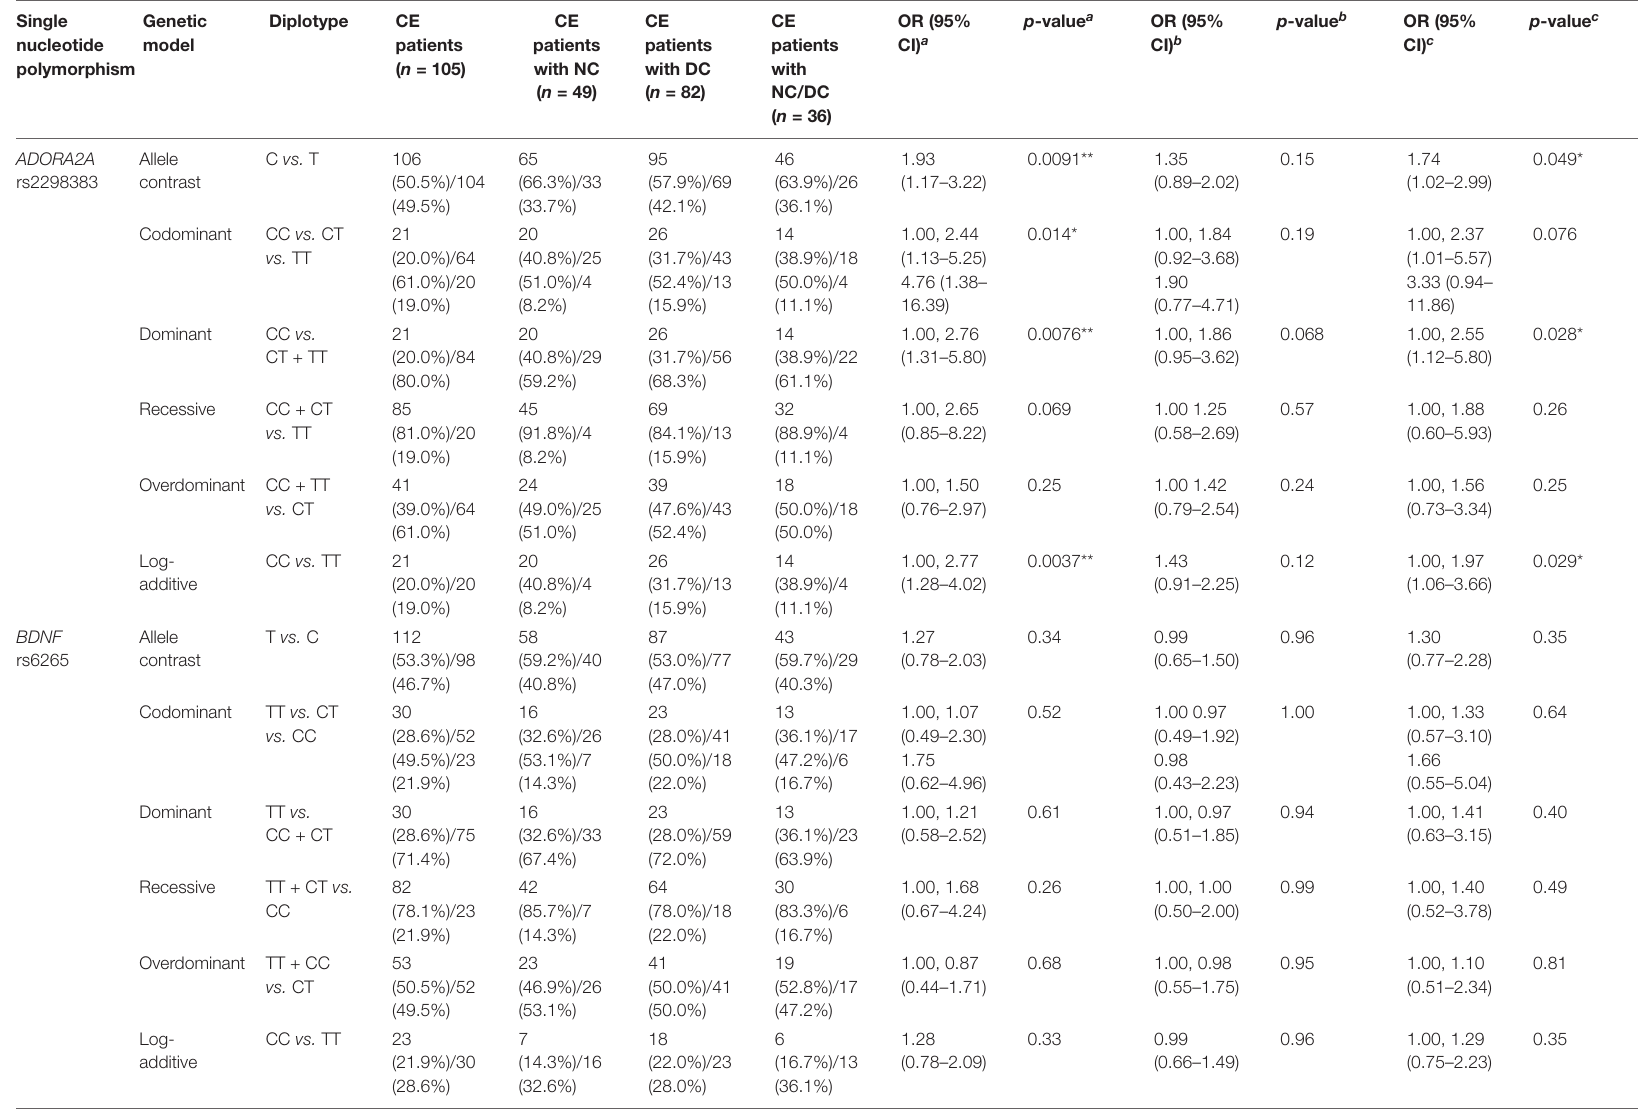
TABLE 3 | Comparison of ADORA2A rs2298383, BDNF rs6265, and NTRK2 rs1778929 diplotype distribution between childhood epilepsy (CE) patients with and without neurologic